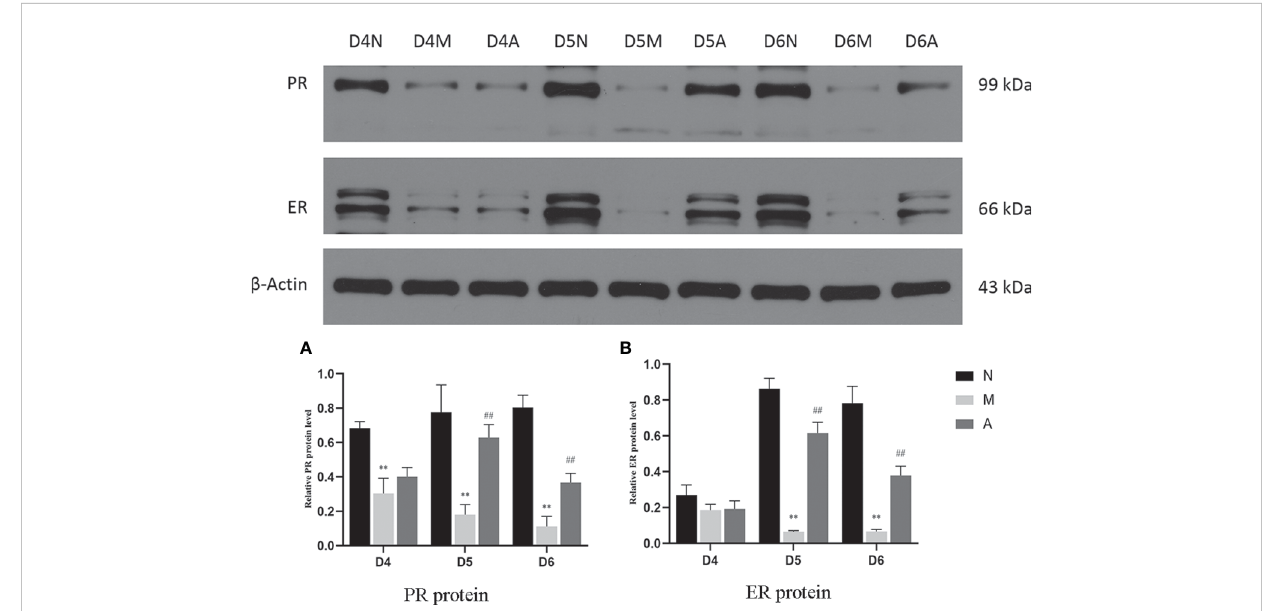
FIGURE 12 The expression of PR (A) and ER (B) protein in the endometrium by West-bolt. *or** represents that there is signi fi cant difference between M and N groups ( P < 0.05 or P < 0.01), #or ## represents that there is signi fi cant difference between A and M groups ( P < 0.05 or P < 0.01). PR, Progesterone receptor; ER, Estrogen receptor; D, The embryo day; N, Normal group; M, Model group; A, Acupuncture